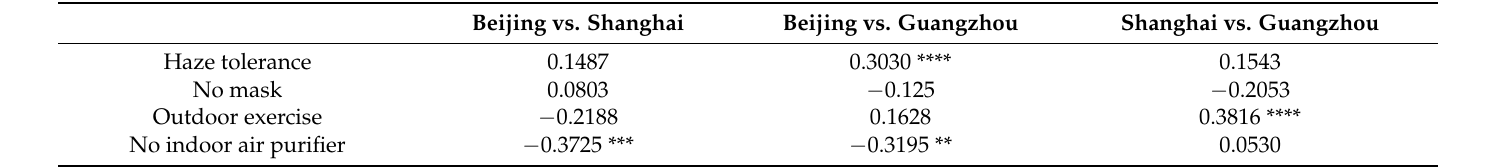
Table 4. ANOVA analysis of tolerance degree among Beijing, Shanghai, and